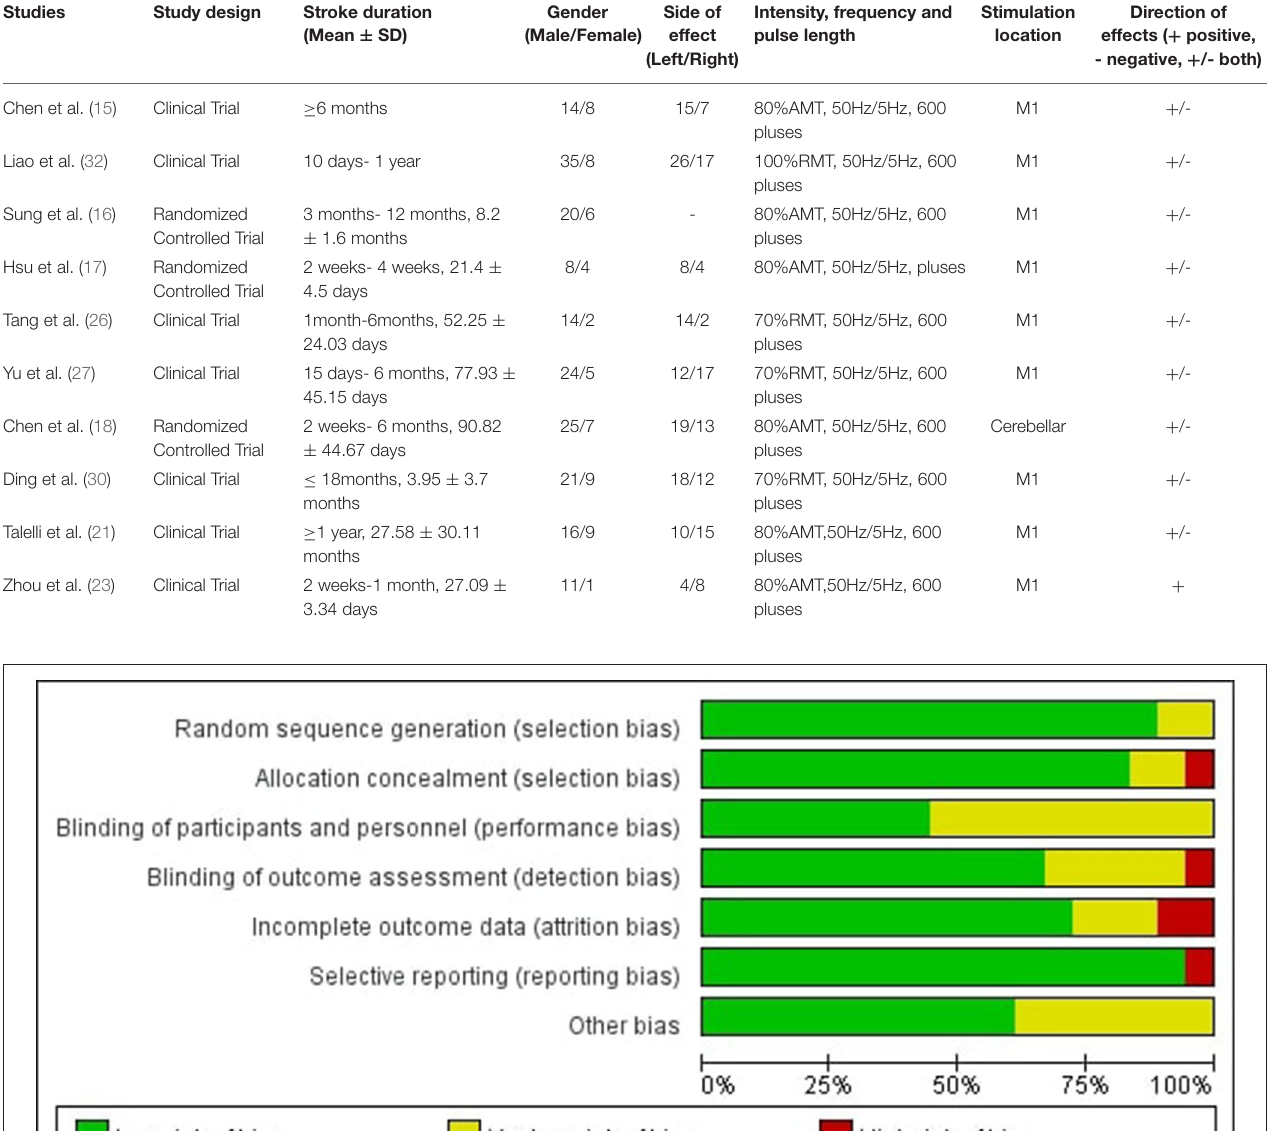
TABLE 2 | Characteristics of studies included in the meta-analysis.